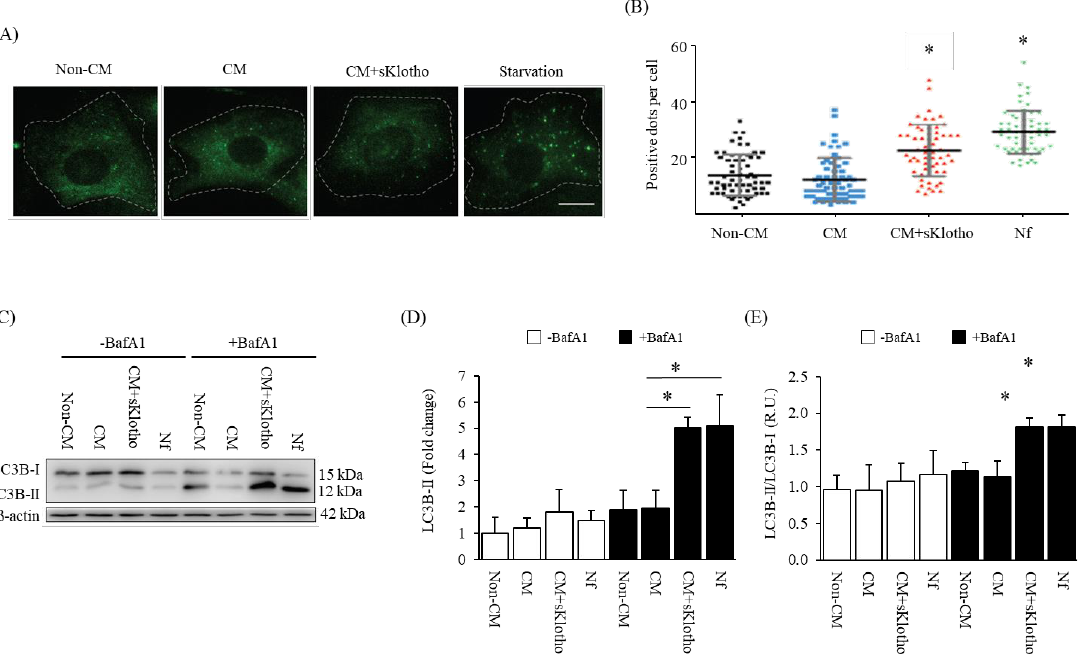
Figure 8. sKlotho effect on autophagy flux in primary vascular smooth muscle cells (VSMCs) ( A ) Representative images of LC3B-II from primary VSMCs exposed to Non-CM, CM and CM+sKlotho for 24 h. An autophagy positive control is shown (Starvation, Nutrient free medium, Nf). ( B ) LC3B- II puncta per cell quantification. All values are expressed relative to Non-CM condition. Mean and